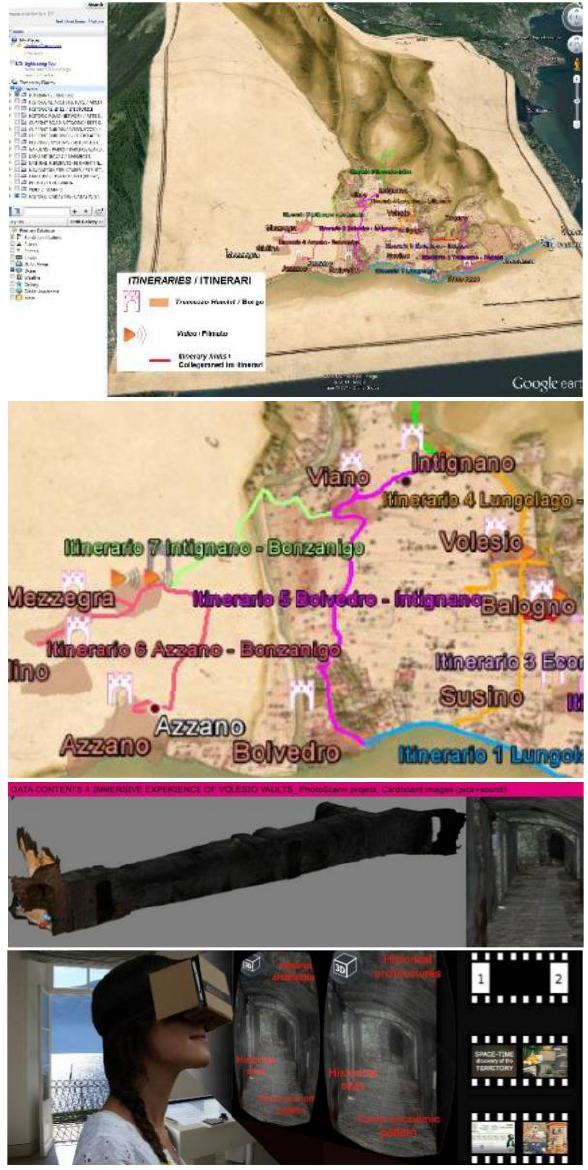
Figure 9. Low cost solution of panoramic